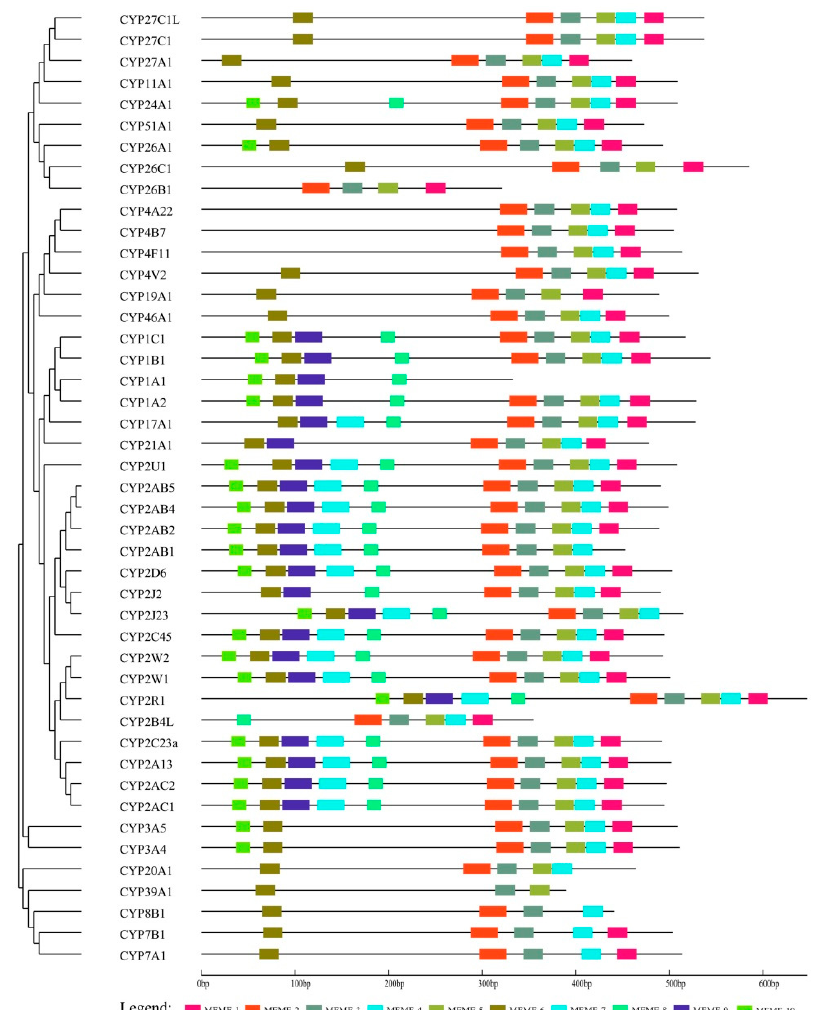
Figure 3. Conserved motifs of cCYPs. All motifs were identified by MEME with the complete amino acid sequences.